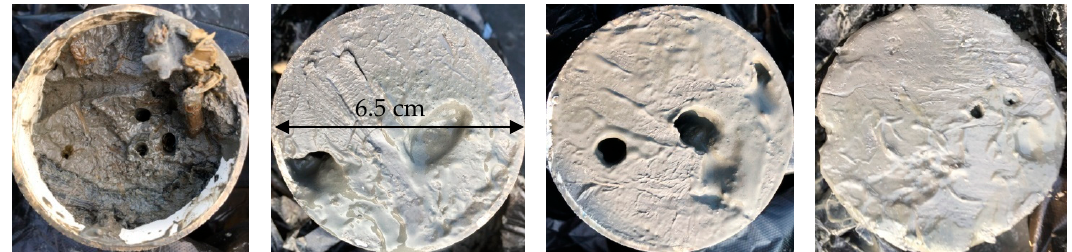
Figure 7. Vertical macropores in the hyporheic zone at a north sampling site of Lake Taihu (left to right represent deep sediment to shallow sediment).